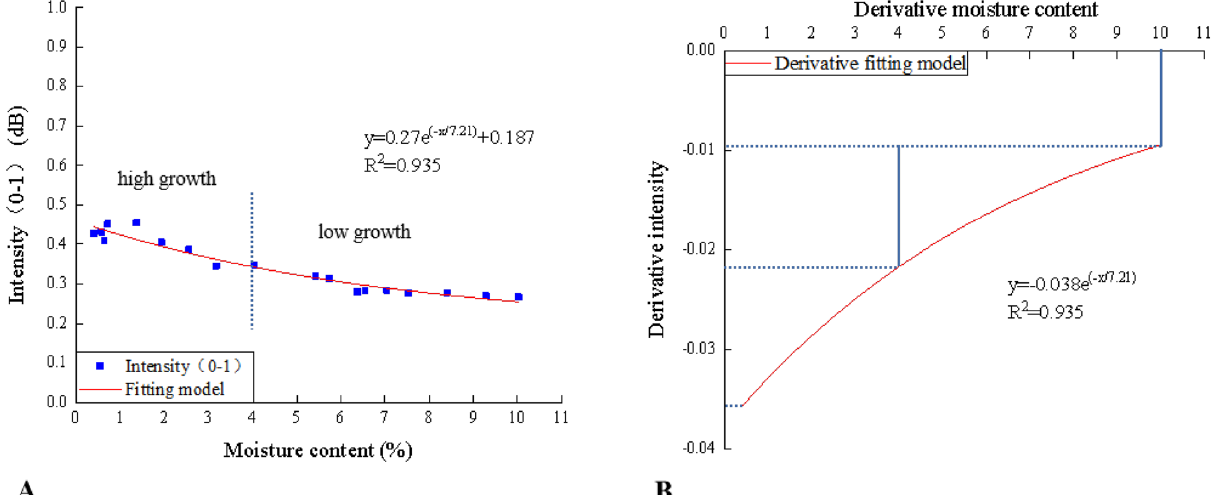
Figure 4. Fitting ( A ) and derivative ( B ) relationships between the laser reflection intensity ( y ) and the moisture content ( x ) of the specimen at 4 m with the normal incidence angle (Software: Riscan pro 2.1; riscan-pro. software.informer.com; Origin 2021b; https:// www. origi nlab. com/ index. aspx? go= PRODU CTS/